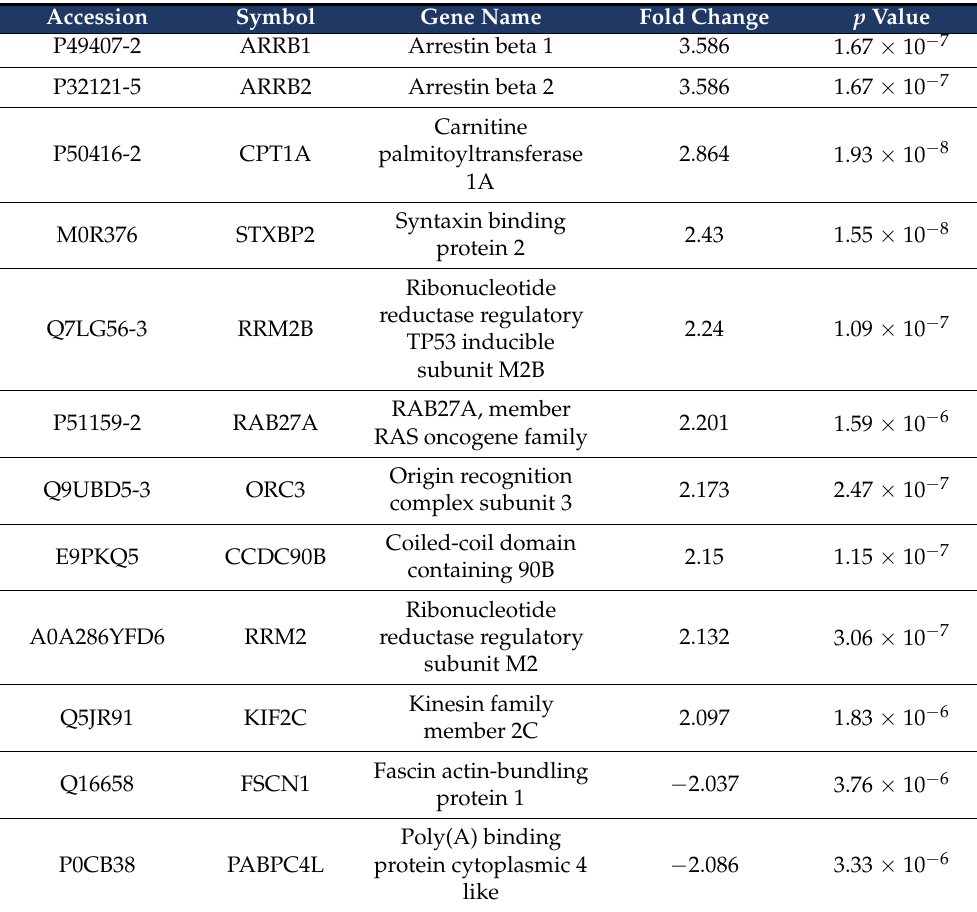
Table 6. Top 20 differentially abundant proteins in RBPMS SG2 vs. EV